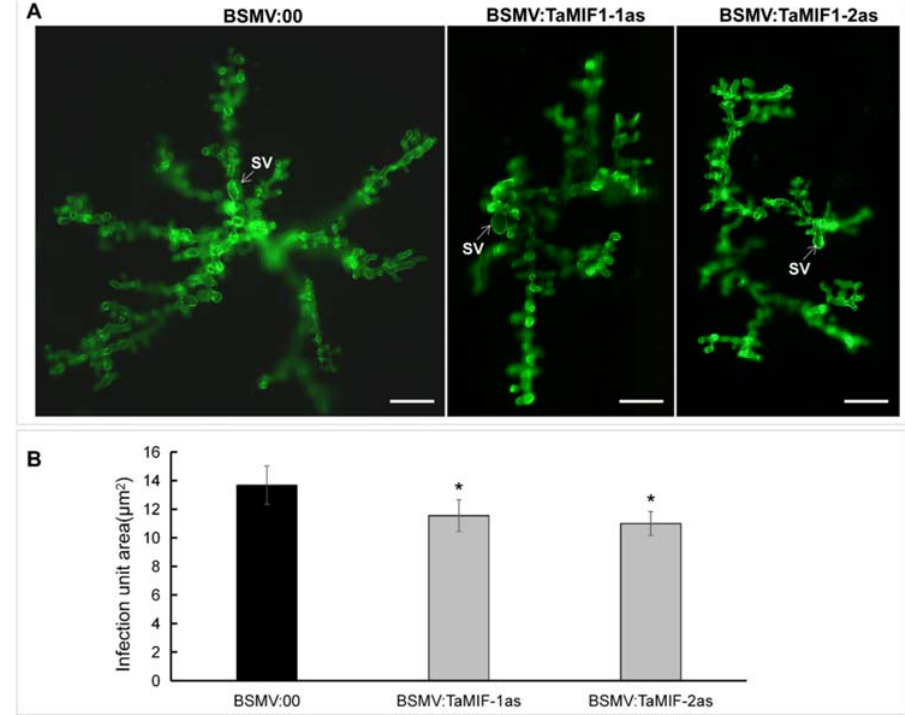
Figure 7. Fungal growth of CYR31 in wheat leaves inoculated with BSMV:00 or BSMV:TaMIF1 at 120 hpi. ( A ) The micrograph of the fungal structure stained by WGA in wheat at 120 hpi. Bars = 50 µ m. ( B ) The statistical data of infected area in wheat at 120 hpi. Results were obtained from 50 infection sites and values represent mean ± SE of three independent replicates. Differences were assessed using Student’s t ‐ tests. Asterisks indicate p < 0.05.